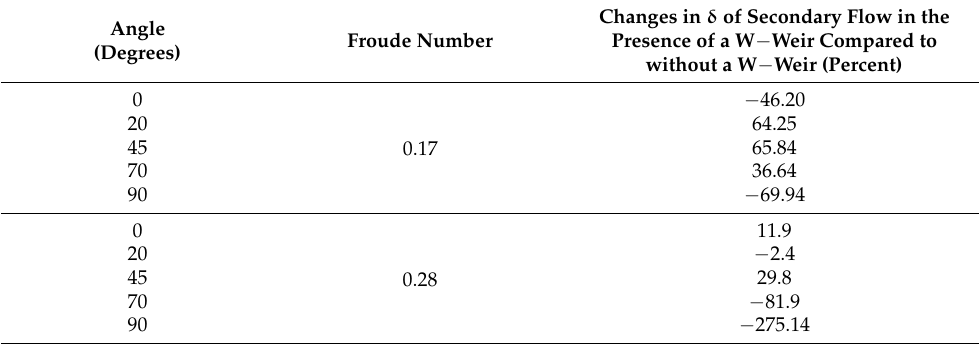
Table 3. The changes in secondary circular power of secondary flow at the associated W − Weir positions, compared to without a W − Weir, for the Froude number values of 0.17 and